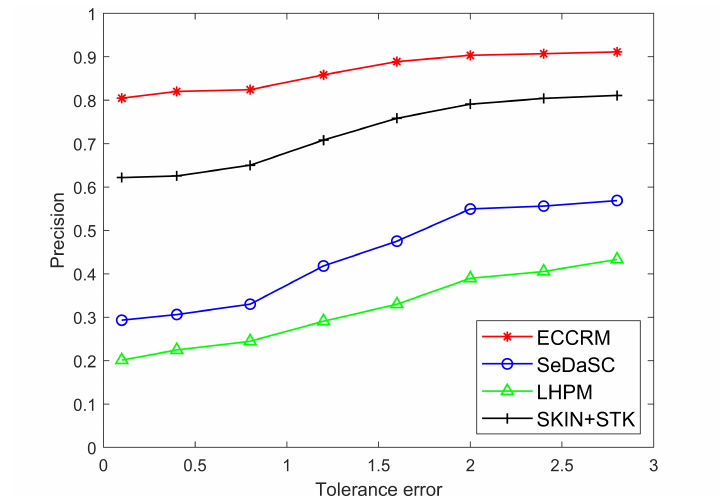
Figure 8. Comparison of precision of hot entities under different tolerance